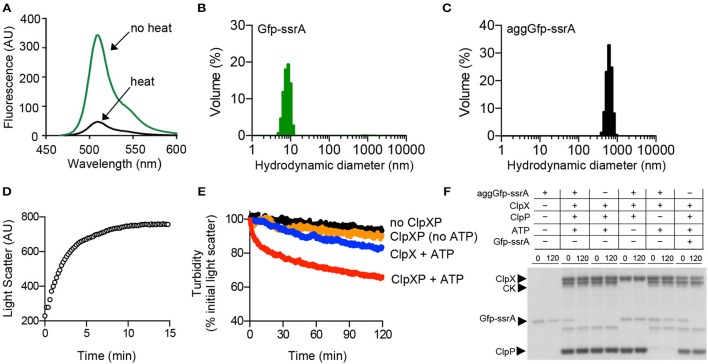
Disaggregation and degradation of aggregated Gfp-ssrA by ClpXP. (A) The fluorescence emission spectra (450–600 nm) of Gfp-ssrA (1.0 μM) (green) and heat-treated Gfp-ssrA (1.0 μM) (black) (85°C for 15 min) were measured using an excitation wavelength of 395 nm. Plotted curves are representative of three traces. (B) DLS was performed for Gfp-ssrA (1.0 μM) (green) as described to determine particle size (nm) distribution. (C) DLS was performed for heat-treated Gfp-ssrA (aggGfp-ssrA) (1.0 μM) (black) as described to determine particle size (nm) distribution. (D) Aggregation by 90°–angle light scatter was measured for Gfp-ssrA (1.5 μM) (open circles) in a cuvette attached to a circulating water bath held at 80°C. Light scattering was monitored for 15 min. (E) Disaggregation of aggGfp-ssrA (1 μM) was monitored by 90°–angle light scatter as described in Materials and Methods. Disaggregation reactions contained aggGfp-ssrA (1 μM) (black circles), ClpX (0.5 μM) and ATP (blue circles), ClpX (0.5 μM), and ClpP (0.6 μM) (gold circles), ClpX (0.5 μM), ClpP (0.6 μM), and ATP (4 mM) (red circles), and a regenerating system, where indicated. Light scattering was monitored for 120 min. Curves shown are representative of at least three replicates. (F) Degradation of Gfp-ssrA and aggGfp-ssrA was monitored as described in Materials and Methods in reactions containing Gfp-ssrA (1 μM) or aggGfp-ssrA (1 μM), where indicated, and ClpX (0.5 μM), ClpP (0.6 μM), ATP (4 mM), and a regenerating system, where, indicated. Reactions were incubated at 23°C for 120 min and samples were analyzed by SDS-PAGE and Coomassie stain.